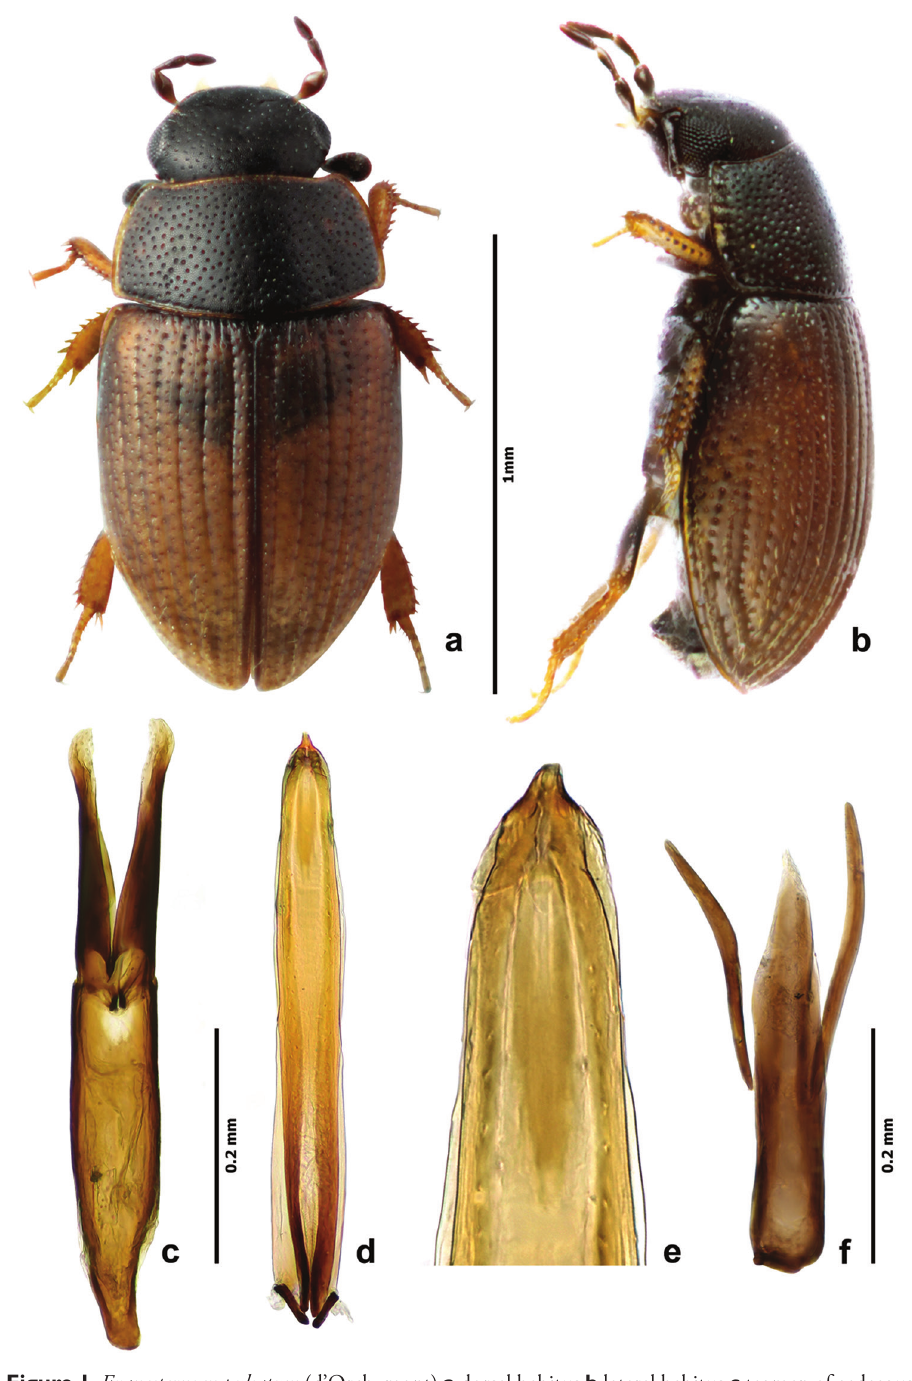
Figure 1. Evanesternum pulsatum (d’Orchymont) a dorsal habitus b lateral habitus c tegmen of aedeagus d median lobe of aedeagus e detail of apex of median lobe f 9 th